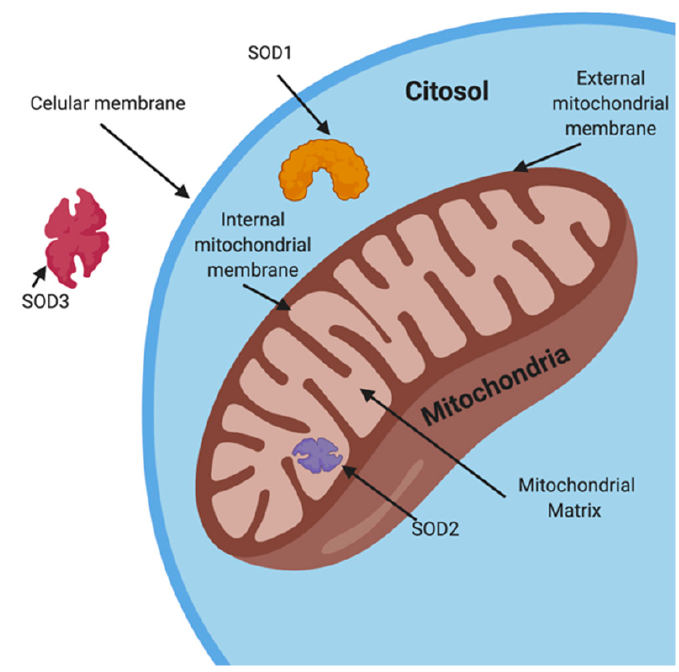
Figure 2. Location of SOD group in relation to cell and mitochondria. SOD1 (Cytosolic SOD or CuZn-SOD). SOD2 (Mitochondrial SOD or Mn-SOD). SOD3 (tetrameric extracellular SOD or EC- SOD).